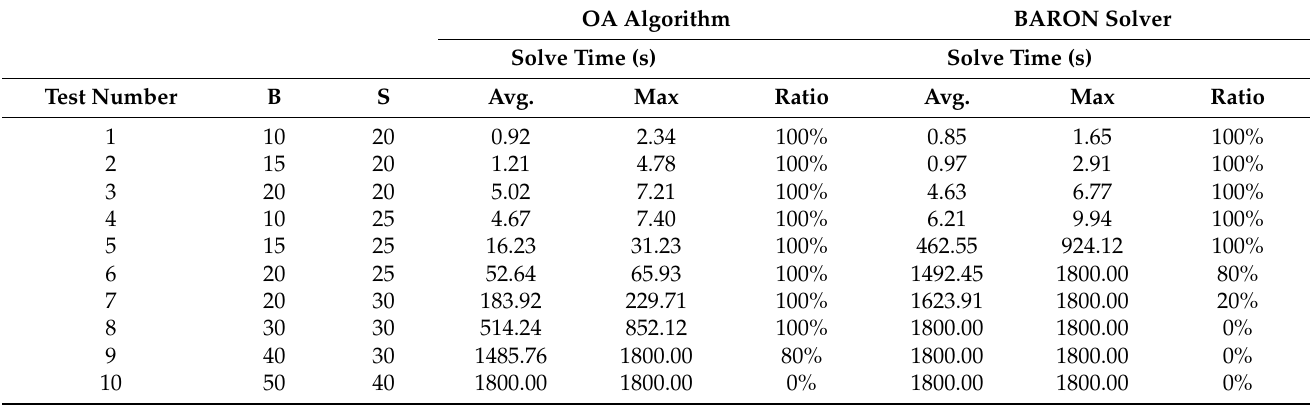
Table 5. Comparison of computational performance of the OA algorithm and BARON